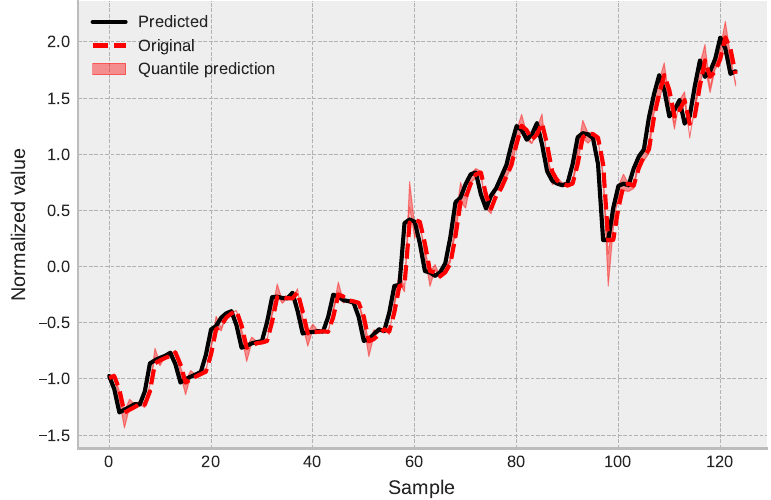
Figure 8. Regression and quantile regression of the tuned optimal model.